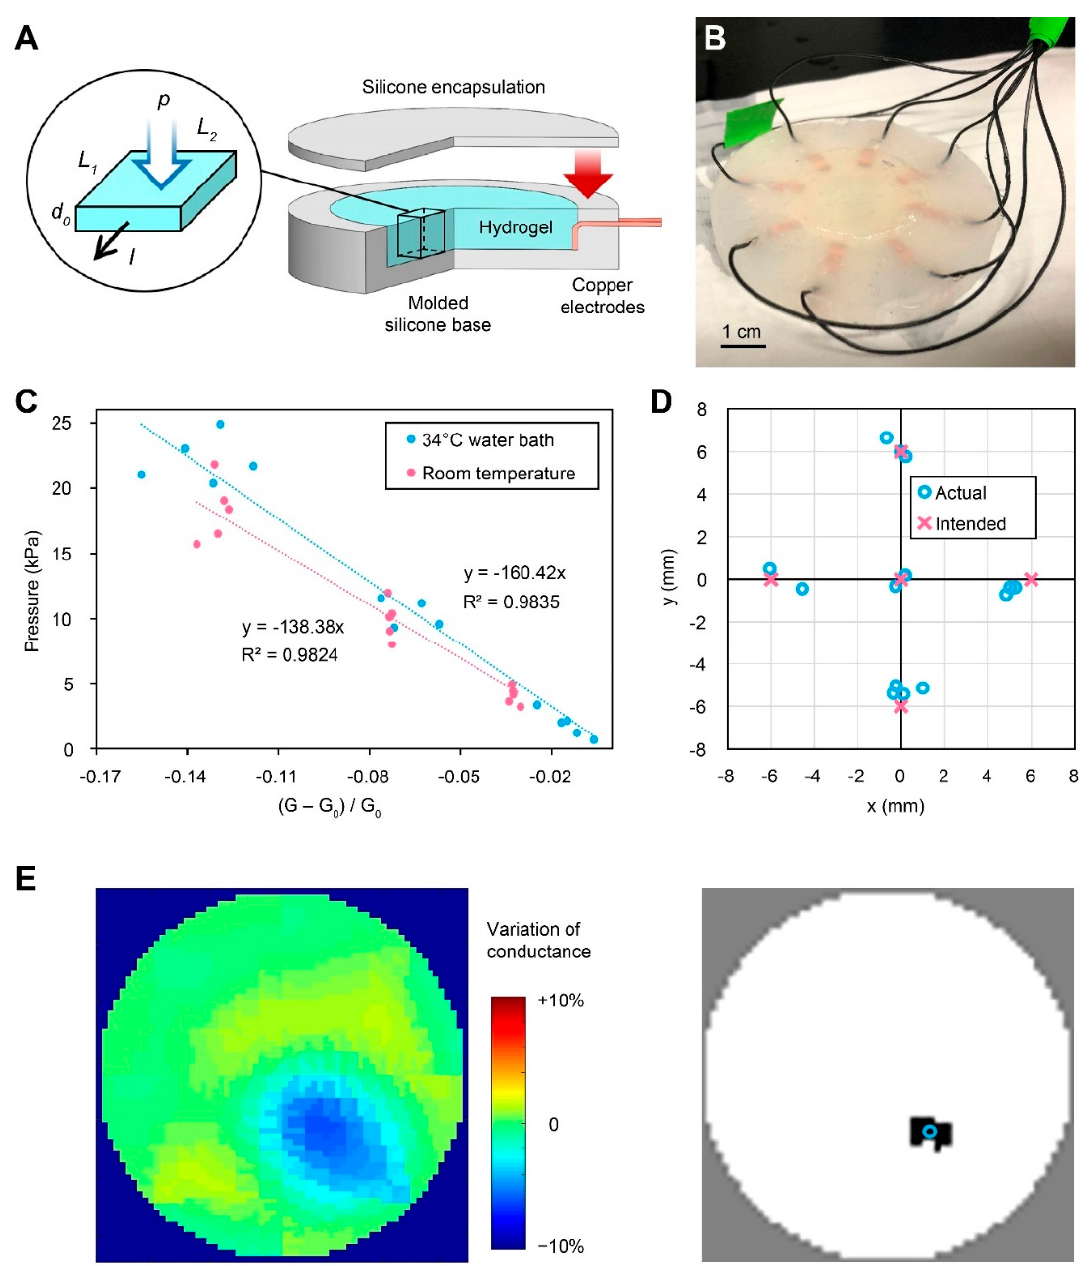
mm thickness, 30 mm diameter) reduced the impact of its higher compressive modulus (Figure S1) to the soft hydrogel layer underneath.